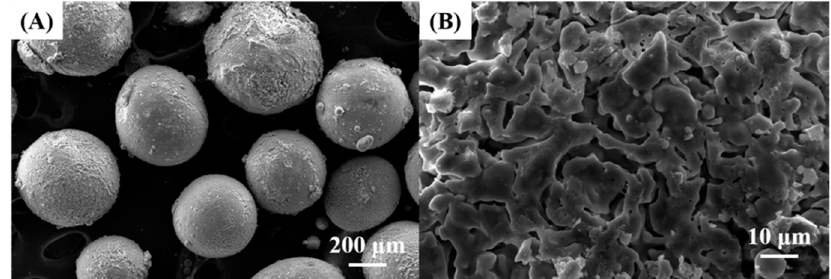
Figure 2. Representative SEM images of synthesized hydroxyapatite (HA) microspheres displaying ( A ) well-defined spherical shape and ( B ) relatively rough surface. ( A ) well-defined spherical shape and ( B ) relatively rough